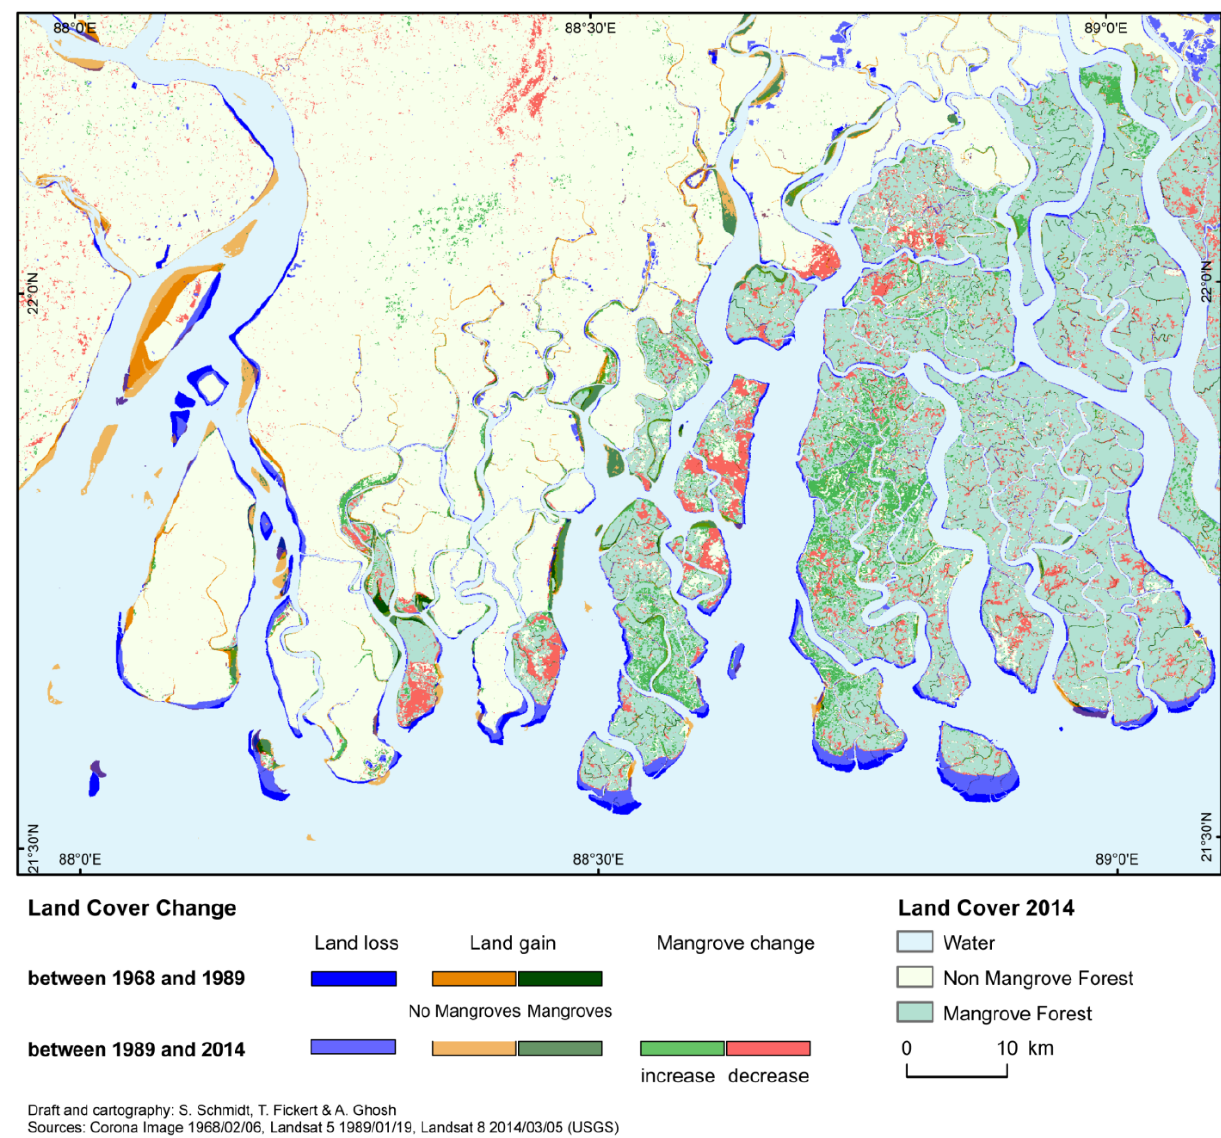
Figure 4. Change detection analyses indicating areas of land loss and land gain between 1968 and 2014 based on Corona and Landsat data; for changes in mangrove extent and cover only the Landsat data were employed; for change statistics see Table